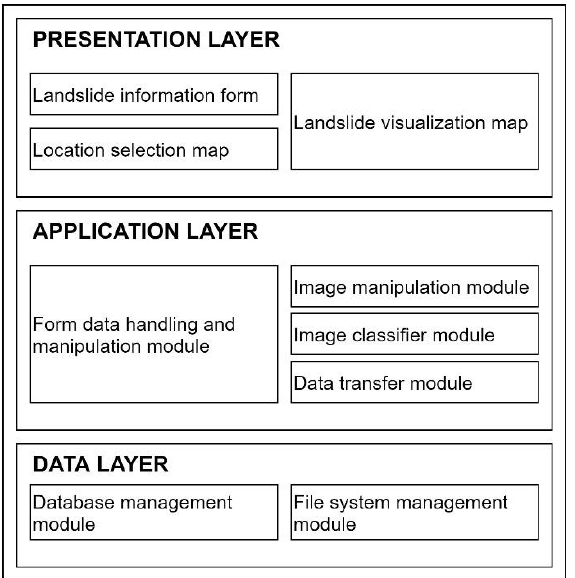
Figure 1. Main components of the developed WebGIS platform (except the mobile app LaMA, which was already presented by Kocaman and Gokceoglu, 2019a).